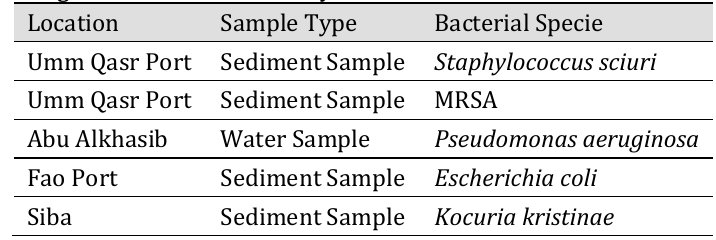
Table 3. Sources of biofilm-forming bacterial species used as targeted bacteria in the